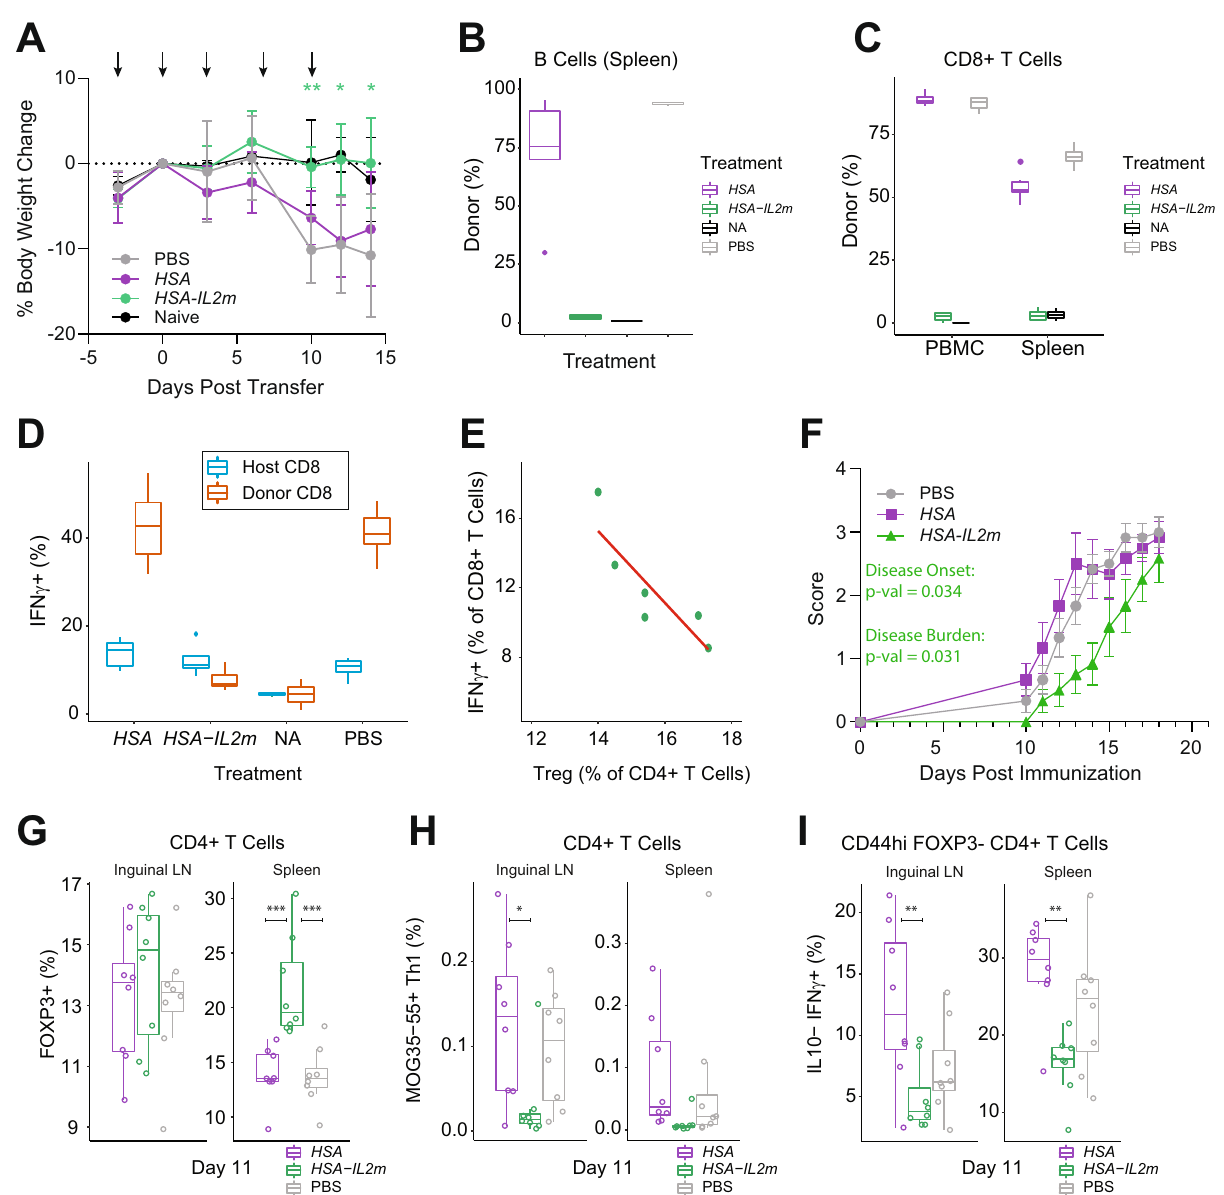
Fig. 6 IL2 mutein is ef fi cacious in acute GvHD and EAE mouse models. Acute GvHD model: A Body weights of F1 animals following adoptive transfer of B6 cells. Animals ( n = 6 for all groups except n = 2 for NA group) were dosed on days − 3, 0, 3, 7 and 10 as indicated by arrows. Asterisks denote signi fi cance (two-way ANOVA, two-sided, p -value * < 0.05, ** < 0.01) compared to PBS group and data are presented as mean ± s.d. Frequency of donor B B cells and C CD8 T cells. D Frequency of IFN γ producing CD8 T cells. E correlation of Treg frequency and CD8 T cell IFN γ expression. EAE model: animals were dosed on days − 3, 0, 3 and 6. F Disease score in murine EAE model ( n = 12), statistics shown for HSA-IL2m against both PBS and HSA groups (Kruskal – Wallis). G Frequency of Tregs (FOXP3 + ) among CD4 T cells in spleen and inguinal lymph nodes ( n = 8). H Frequency of MOG-speci fi c (Tetramer + , Supplementary Fig. 15) Th1 (T-bet + ) cells in spleen and inguinal lymph nodes ( n = 8). I Frequency of IFN γ expression in splenic antigen experienced CD4 T cells ( n = 8). Asterisks denote signi fi cance (two-way ANOVA, two-sided, p -value * < 0.05, ** < 0.01, *** < 0.001). Box plots center is the median, bounds of box are 1st and 3rd quartile. Upper whisker is the largest value that is no greater than 1.5× the interquartile range plus the third quartile. Lower whisker is the smallest value that is no smaller than the fi rst quartile minus 1.5× the interquartile range. Source data are provided as a Source Data fi